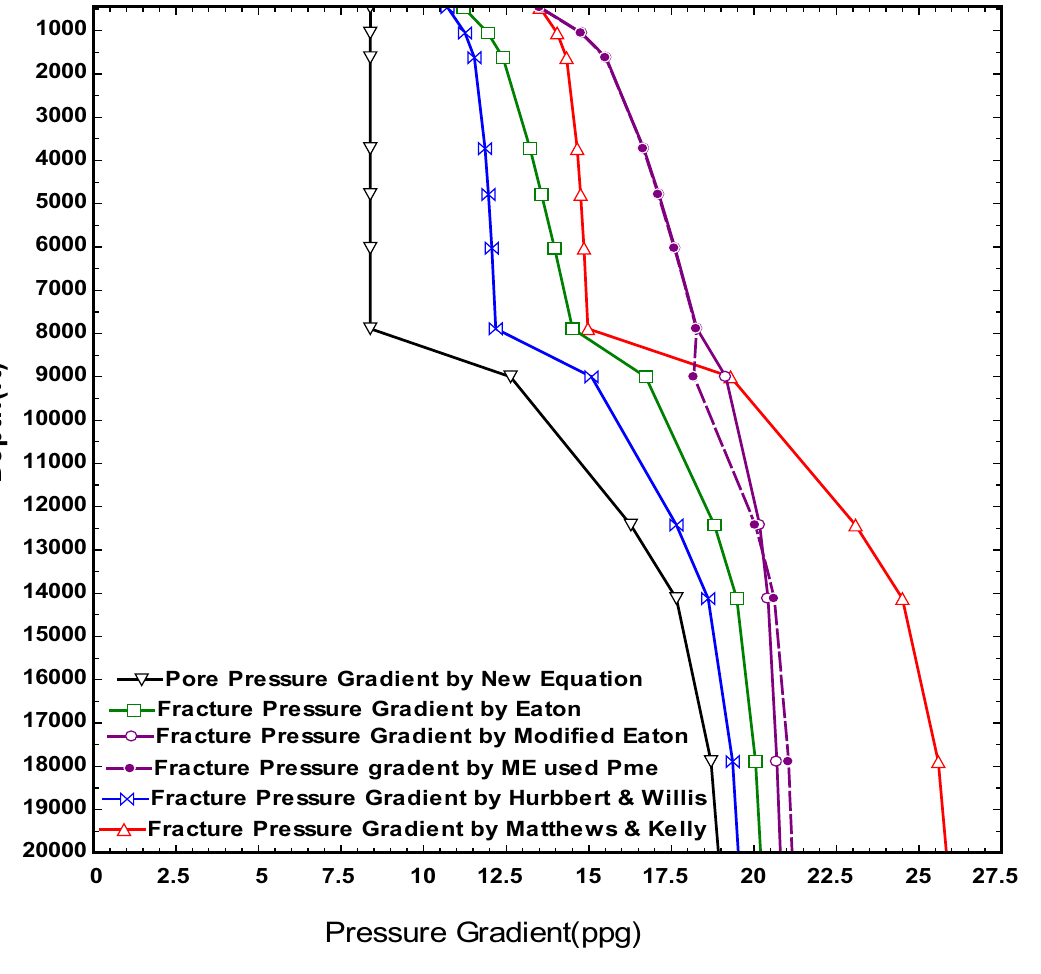
Fig. 9 Fracture pressure gradient calculated using pore pressure predicted by new